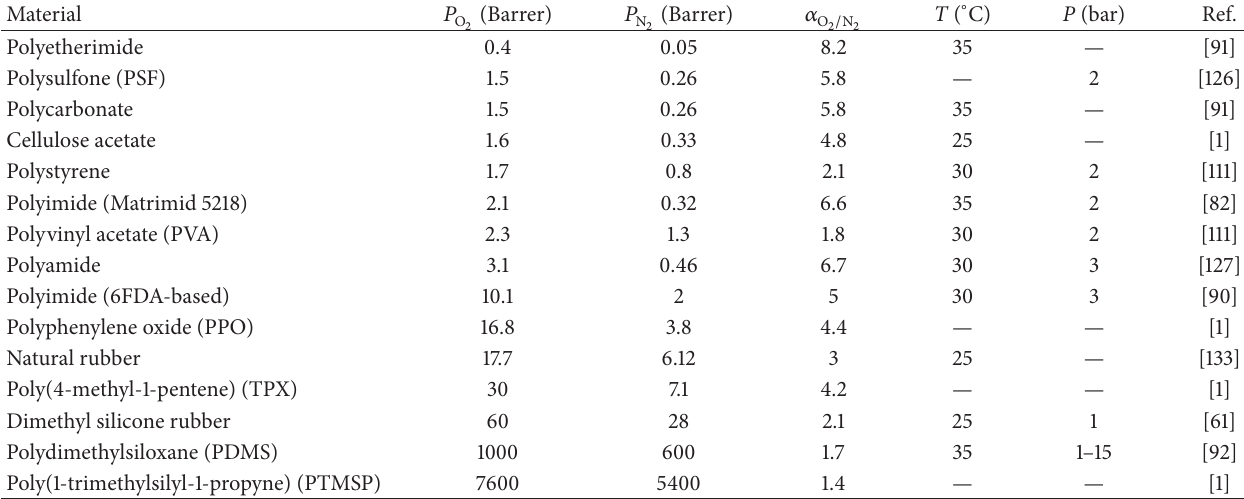
Table 8: Oxygen and nitrogen permeabilities of different polymeric materials.